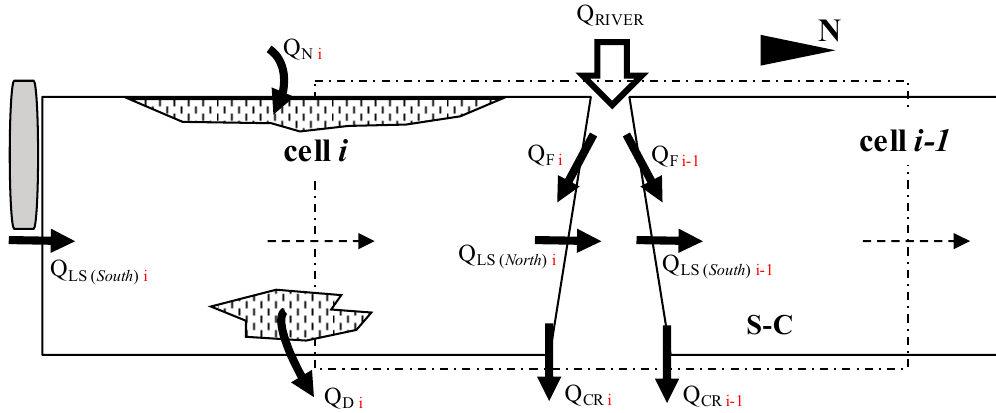
Figure 2. Sediment balance diagram. Littoral cells are limited by morphological features (continuous line). The inclusion of river sediment transport in the balance equations would be straightforward if the cell control volume extended to the dash-dot box.